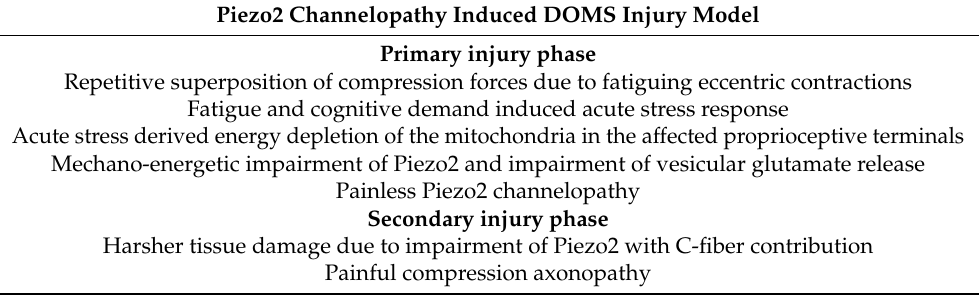
Table 1. The two phases of DOMS adapted from the quad-phasic non-contact injury model [56]. Piezo2 Channelopathy Induced DOMS Injury